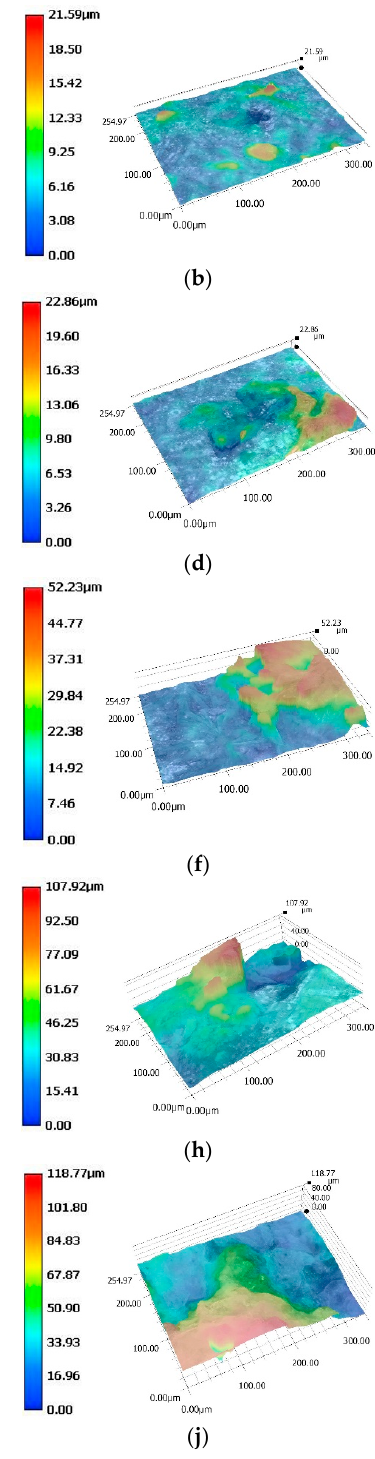
Figure 6. Surface morphologies of C 2 samples after being immersed in 3.5 wt.% NaCl solution for different immersion time: ( a ) 2 h, ( c ) 4 h, ( e ) 6 h, ( g ) 16 h, and ( i ) 24 h. Images ( b ), ( d ), ( f ), ( h ), and ( j ) are the 3D images of the images ( a ), ( c ), ( e ), ( g ), and ( i ), respectively.